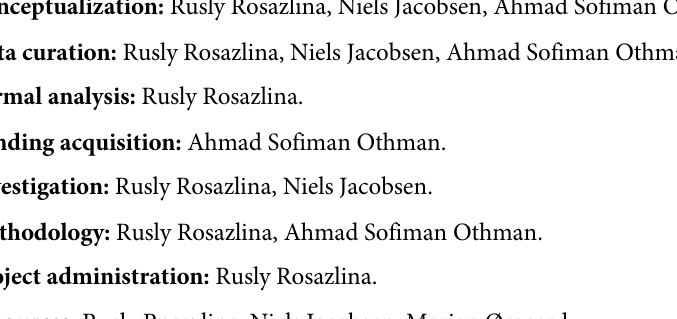
S1 Table. Variable sites of ITS between the clone accession numbers and the putative parental